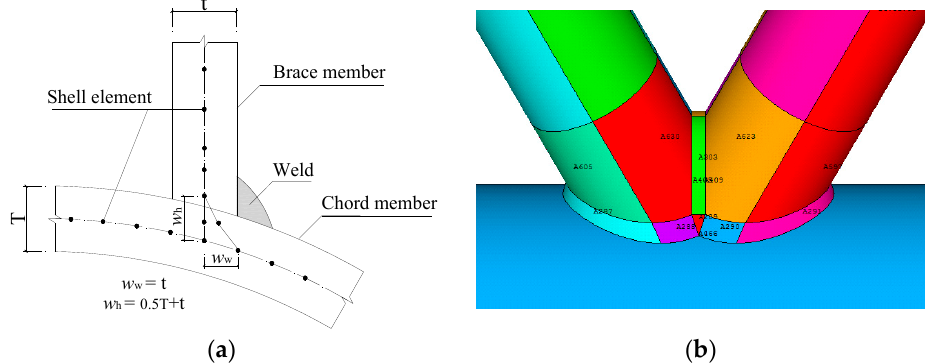
Figure 12. Weld modeling. ( a ) Detailed structure of weld; ( b ) Finite element model of weld.